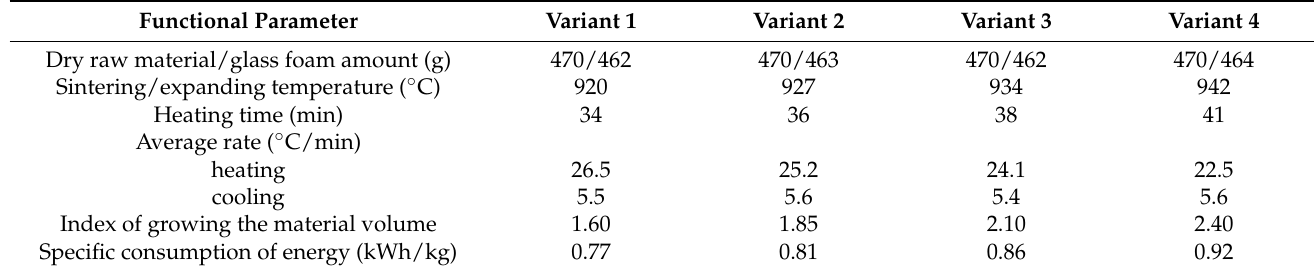
Table 3. Main functional parameters of the heat treatment process.